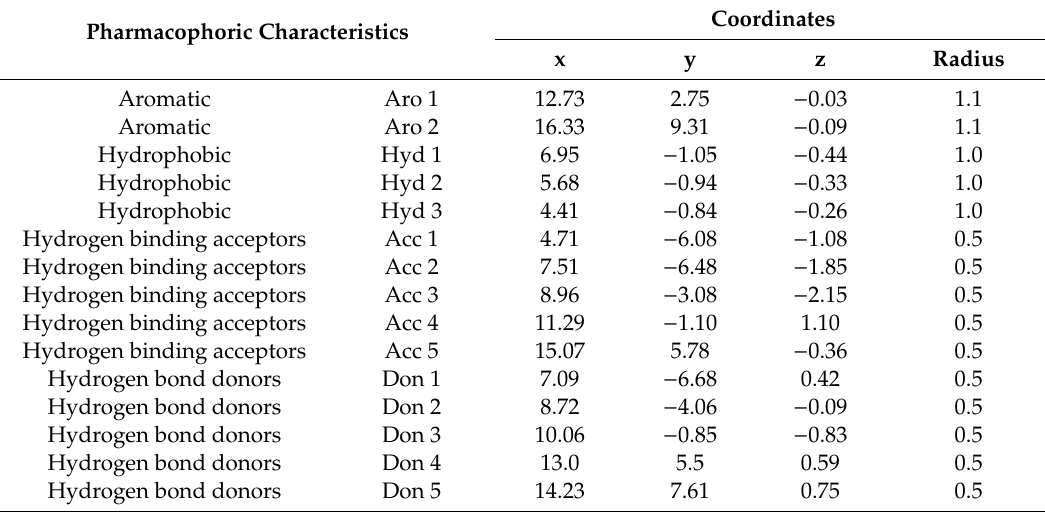
Table 3. Spatial coordinates of the pharmacophoric